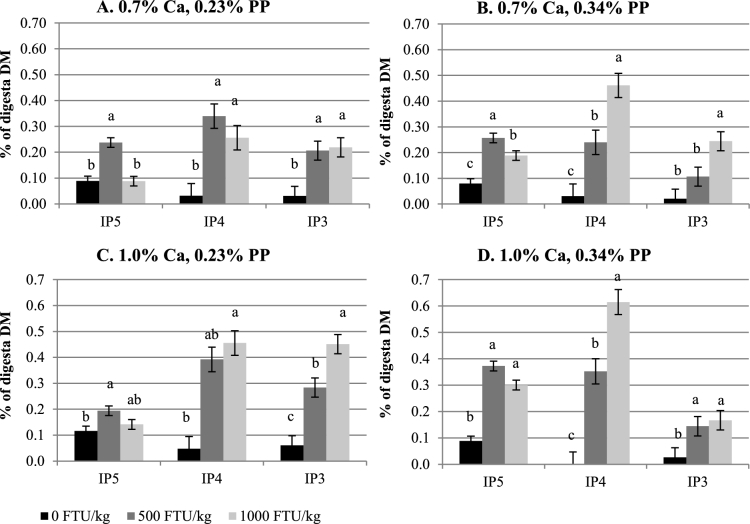
Effect of phytase on ileal inositol phosphate ester (IP3–5) concentrations (mean±SEM). a-c Comparisons were made within the same IP ester group. Means with different superscript letters differ.